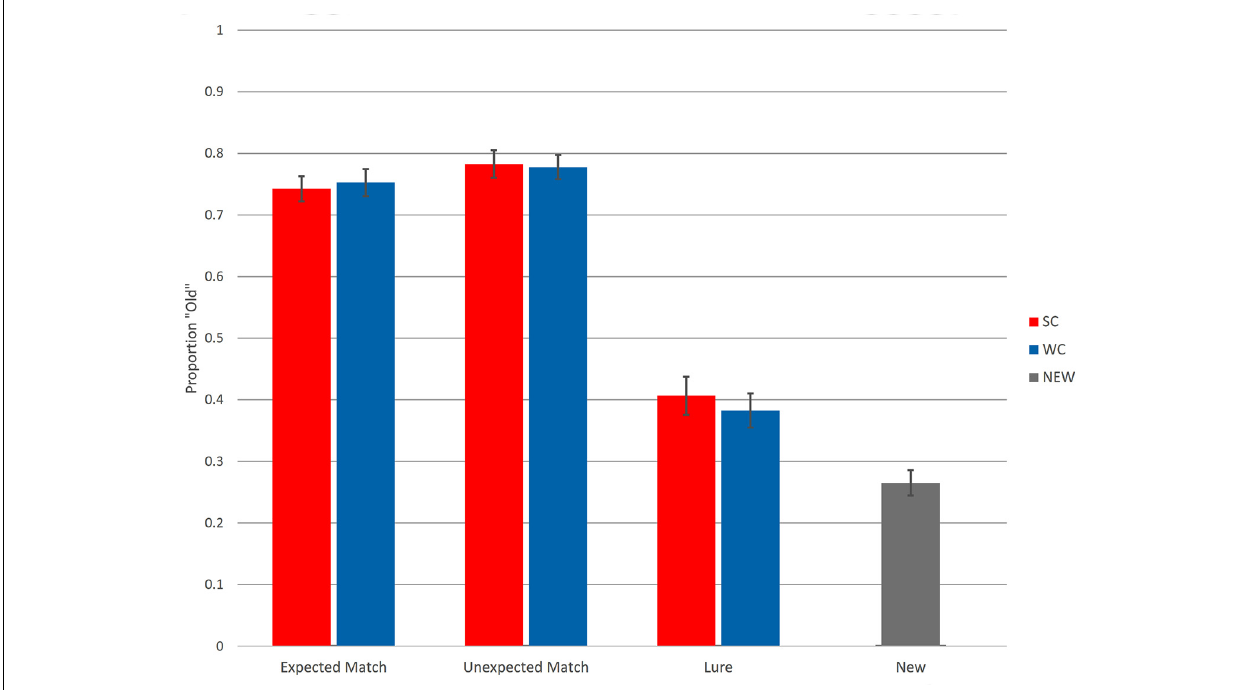
FIGURE 1 | Recognition memory accuracy. Proportion “Old” responses are plotted on the Y axis. SC, strong constraint; W, weak constraint. Error bars reflect standard error around the mean.